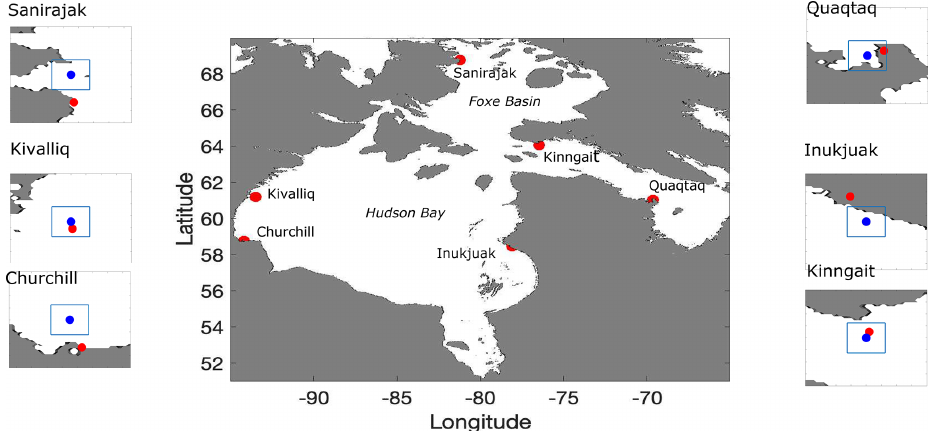
Figure 1. The study region with locations of interest shown in red. The insets show the location of a nearby port or polynya (red) and the nearest point on the model grid (blue) that is outside of the land boundary (where the land mask from ERA5 is less than 0.6), in addition to a bounding box that approximates a grid cell. The ports are Churchill, Inukjuak, and Quaqtaq, whereas the polynyas are near Sanirajak, Kivalliq, and